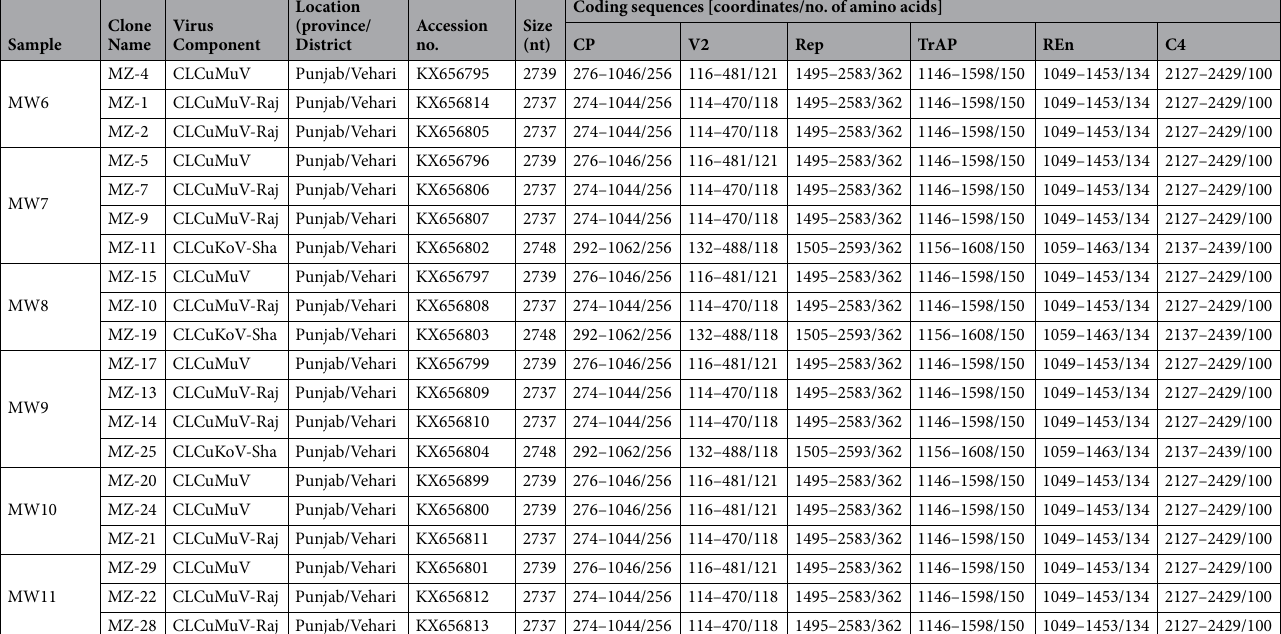
Table 2. Features of begomoviruses obtained from infected cotton samples through Sanger sequencing. Analysis of CLCuMuV-PK isolates showed that they have 92–96%, CLCuMuV-Raj isolates have 96–99% and CLCuKoV-Sha isolates have 96–98% sequence identity with sequences of their respective viruses available in the NCBI database (Figure S1A–C). Three types of alphasatellites, GDarSLA, CLCuBuA and Ageratum conyzoides symptomless alphasatellite (AConSLA) and one type of betasatellite, CLCuMuB were also identified from Sanger sequencing as shown in (Table 3).